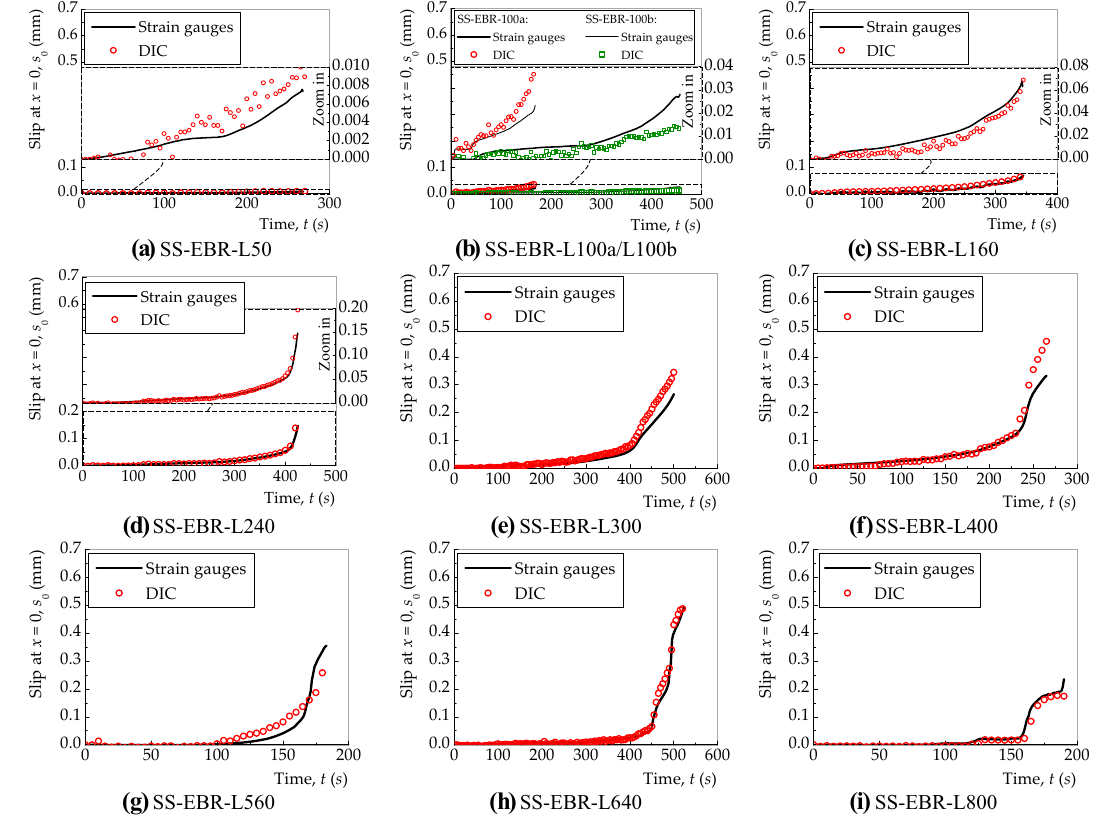
Fig. 7 Comparison between the DIC technique and the strain gauges measurements through the slip at x = 0 versus time